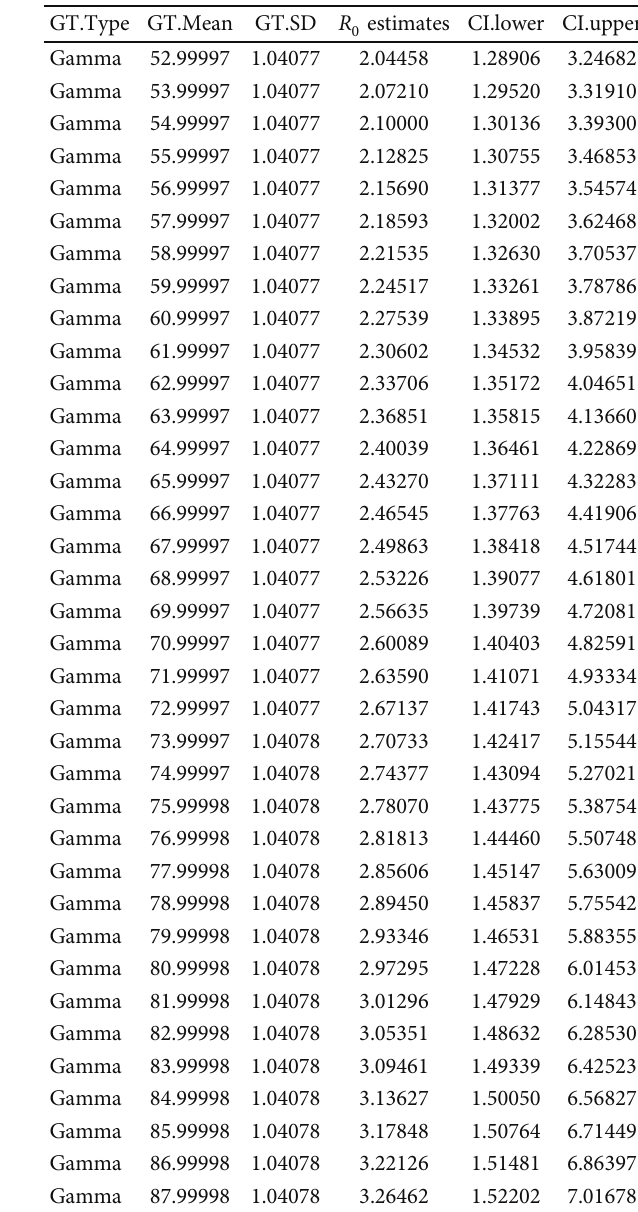
Table 3: Generation time and reproduction number